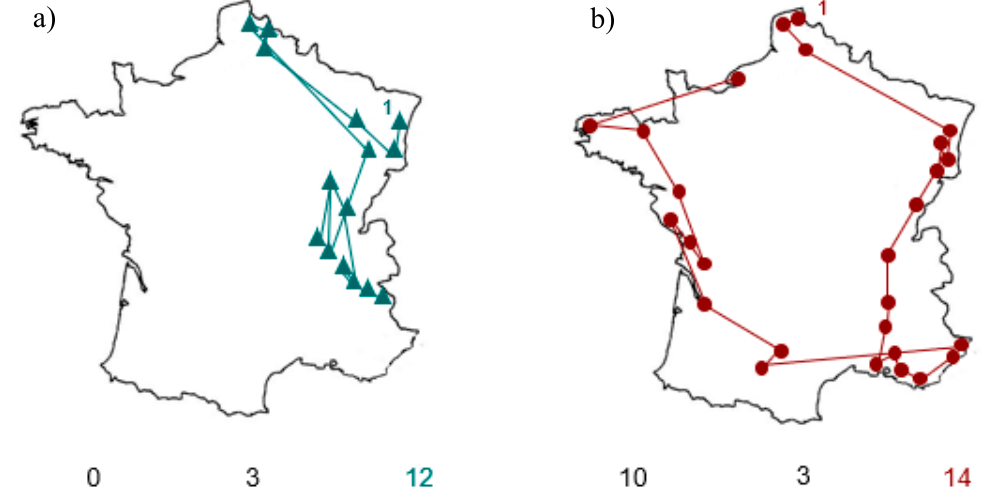
Figure 3. Example of towns named by patient 3 a) before and b) after CVS. Cities are linked following